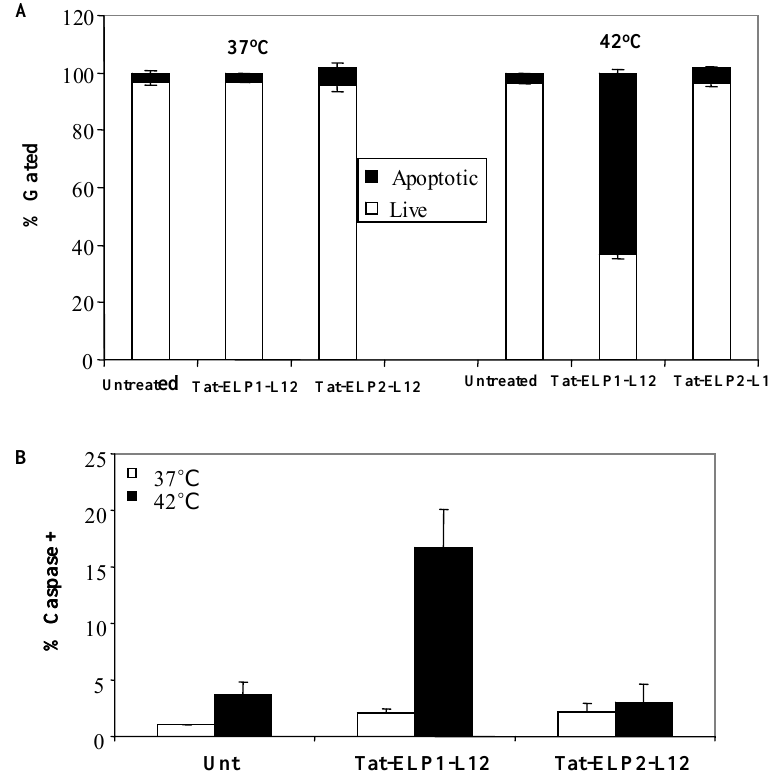
Figure 4. Measurement of Tat-ELP1-L12 induced